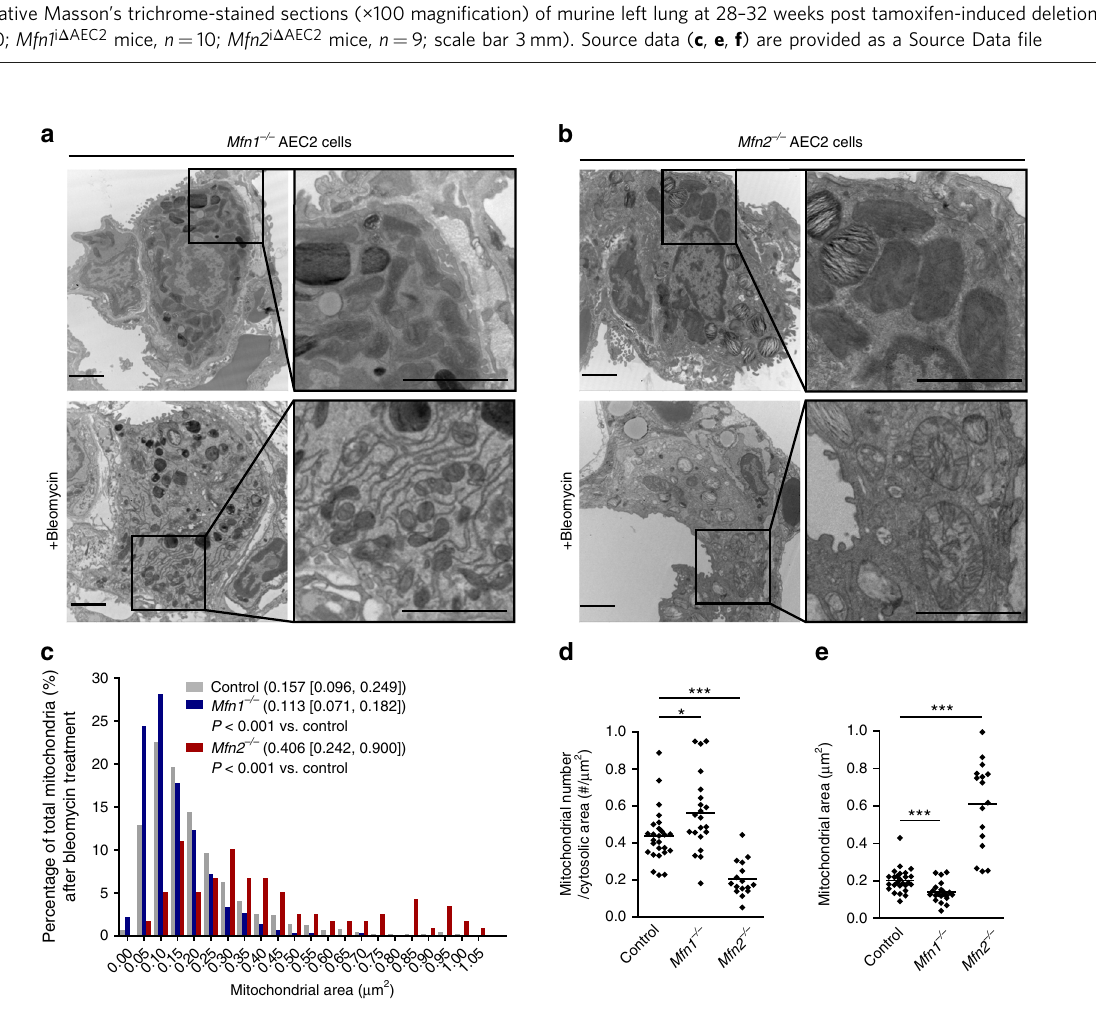
Fig. 3 Mitofusin-de fi cient AEC2 cells susceptible to bleomycin-induced mitochondrial damage. a , b Representative TEM images (12,000X; scale bar 2 μ m) in Mfn1 − / − ( a ) or Mfn2 − / − ( b ) AEC2 cells before ( n = 3 mice) and after bleomycin treatment ( n = 2 mice). c – e Quanti fi cation of mitochondria area of each mitochondrion (control n = 521 mitochondria, Mfn1 − / − n = 464 mitochondria, Mfn2 − / − n = 119 mitochondria; data presented as the median [interquartile range], and the comparison performed by Mann – Whitney U test) ( c ), and mitochondrial number per μ m 2 of cytosolic area ( d ) and mitochondrial area ( μ m 2 ) ( e ) in each AEC2 cell ( d , e , each dot represents one AEC2 cell; * p < 0.05, *** p < 0.001, vs. control by unpaired Student ’ s t test), using TEM images (12,000X) of control, Mfn1 − / − or Mfn2 − / − AEC2 cells 8 days after bleomycin treatment (control AEC2 cells n = 26, Mfn1 − / − AEC2 cells n = 21, Mfn2 − / − AEC2 cells n = 16, from 2 mice per group). Source data ( c – e ) are provided as a Source Data fi